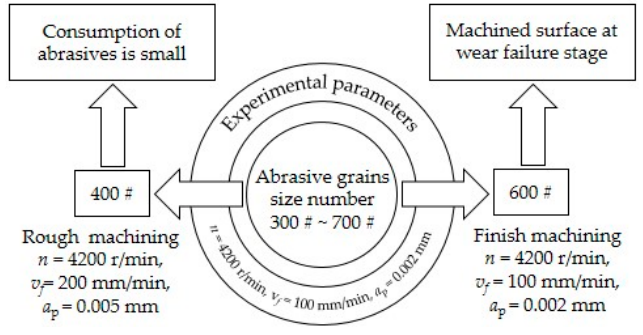
Figure 5. Graphic abstract of grinding experiment.